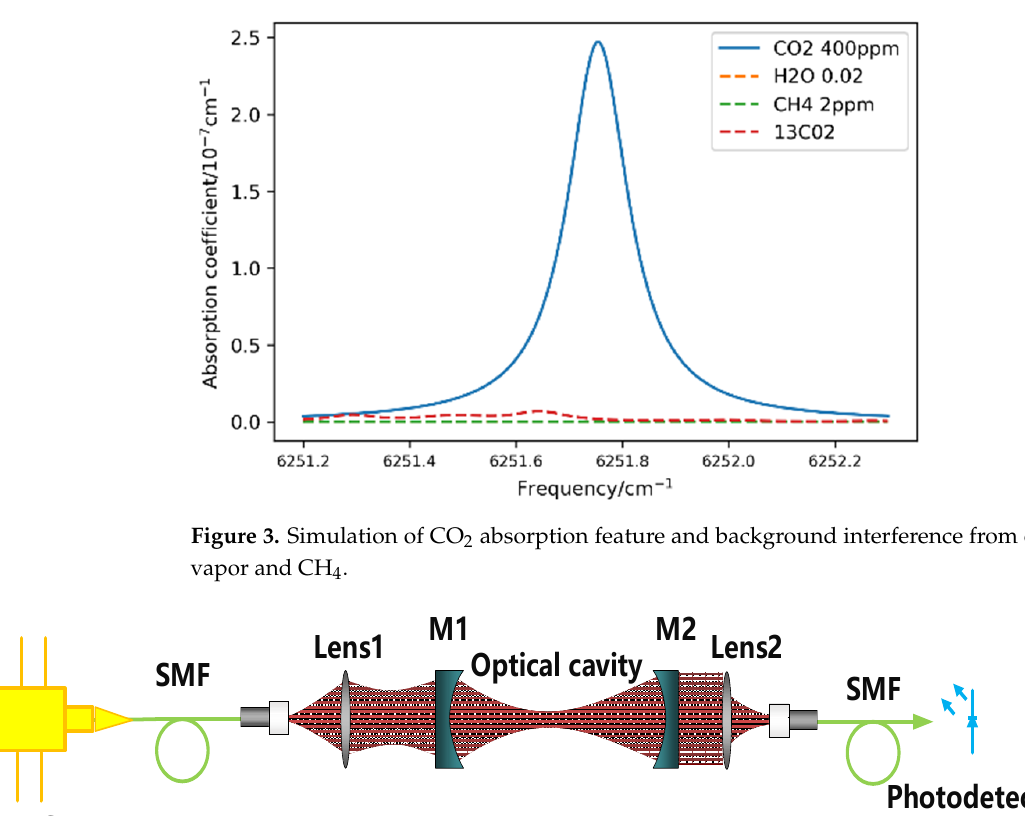
Figure 4. Framework of the optical resonant cavity, SMF: Single mode fiber; M1 and M2: cavity mirrors. Lens1 is a resonant cavity mode matching lens for mode matching of a laser-beam to a high finesse optical cavity. Lens2 is the light converging lens for coupling light into fiber.